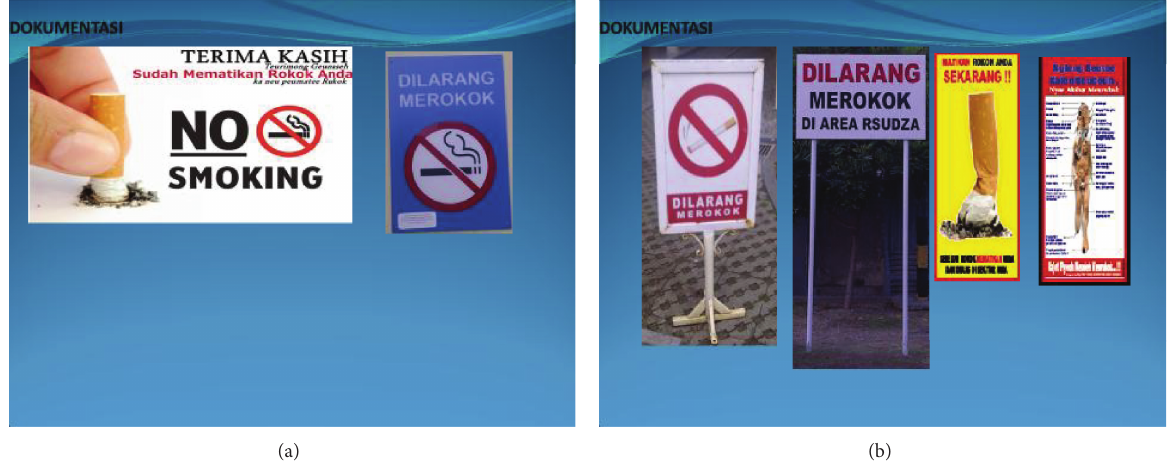
Figure 3: Examples of antismoking wall signs, free-standing signs, and wall posters